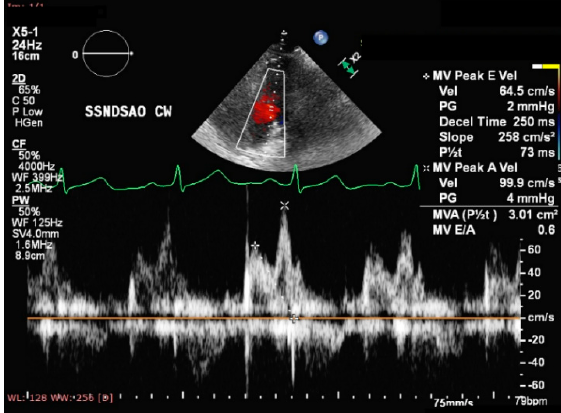
Figure 8. PW Doppler Echocardiography of the same patient showing grade I diastolic dysfunction (impaired relaxation). Prepared by the authors. Courtesy of the Pediatric Clinical Hospital, Lucian Blaga University of Sibiu.